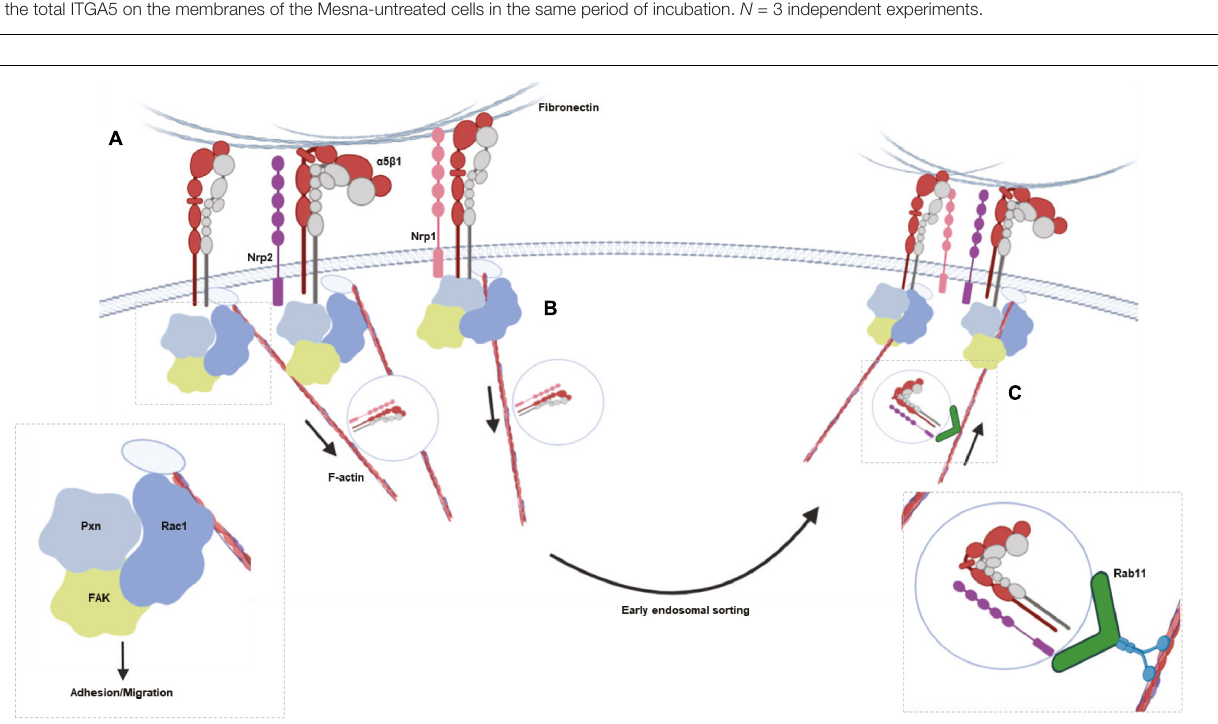
FIGURE 5 | Schematic summarizing the major results. (A) , NRP2 and ITGA5 share an interaction at the cell membrane, promoting EC adhesion and migration on FN matrices by regulating Rac1 activation. (B) , NRP1 is known to selectively stimulate internalization of active α 5 β 1 integrin from fibrillar adhesions along